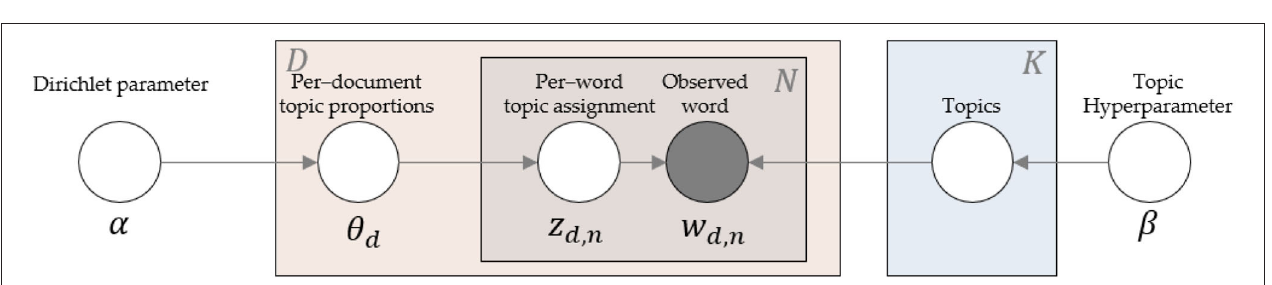
FIGURE 2 | Two-dimensional scatter plot of food name vectors.